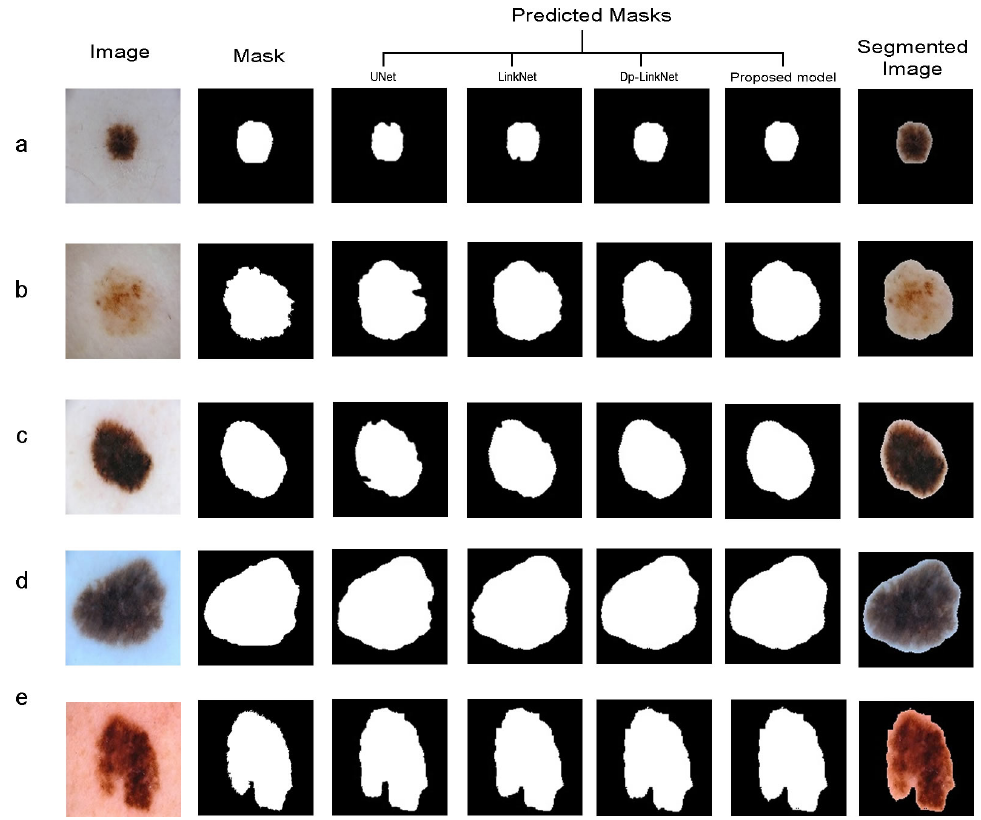
Figure 10. Comparison of models in the lesion segmentation